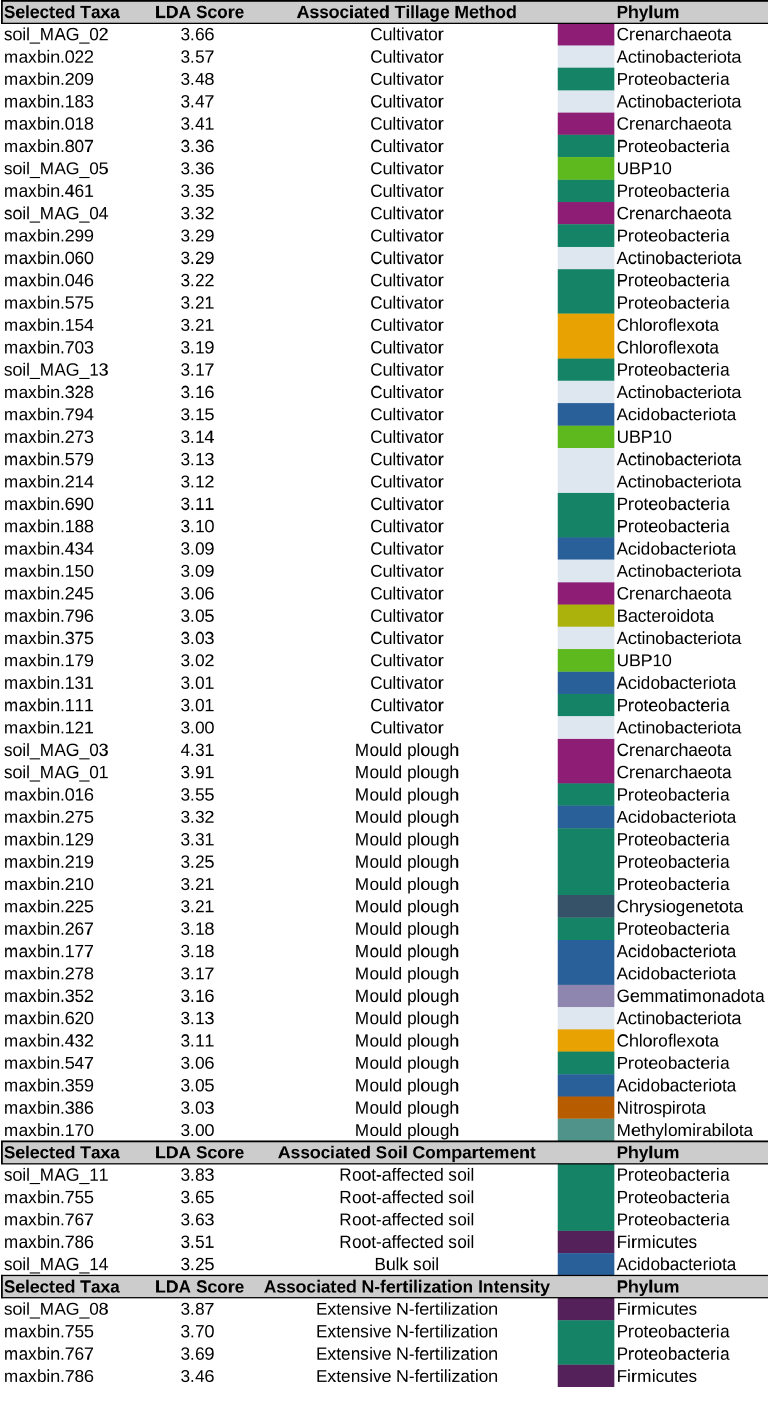
Figure 7. Significantly differentially abundant MAGs. For linear discriminant analysis (LDA) effect size method (LEfSe) [43] analysis, data was grouped by tillage, compartment (bulk soil and root-affected soil) and fertilization. LDA scores estimate the effect size and therefore indicate the degree of consistent difference in relative abundance between features in the two classes of analyzed microbial communities [43]. Color indicates the phylum of each MAG as assigned by GTDBtk (https://github.com/Ecogenomics/GtdbTk; Crenarchaeota corresponds to Thaumarchaeota in the NCBI